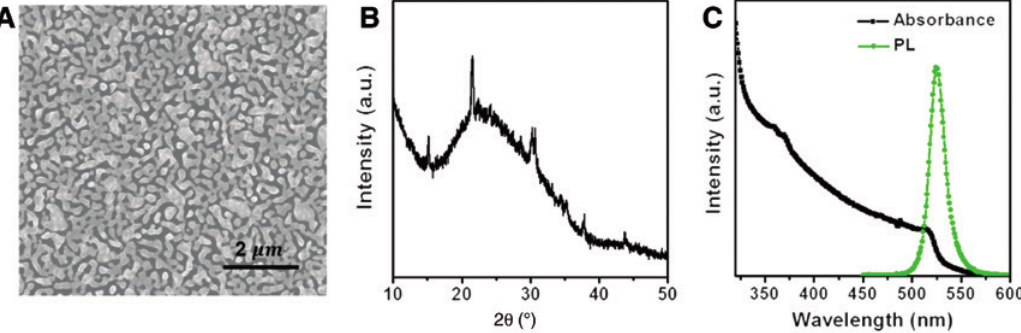
perovskite thin film characteristics. Figure 2: CsPbBr 3 (A) Top view SEM image, and (B) XRD spectrum measured for the CsPbBr and (C) absorption and PL spectra measured for the CsPbBr